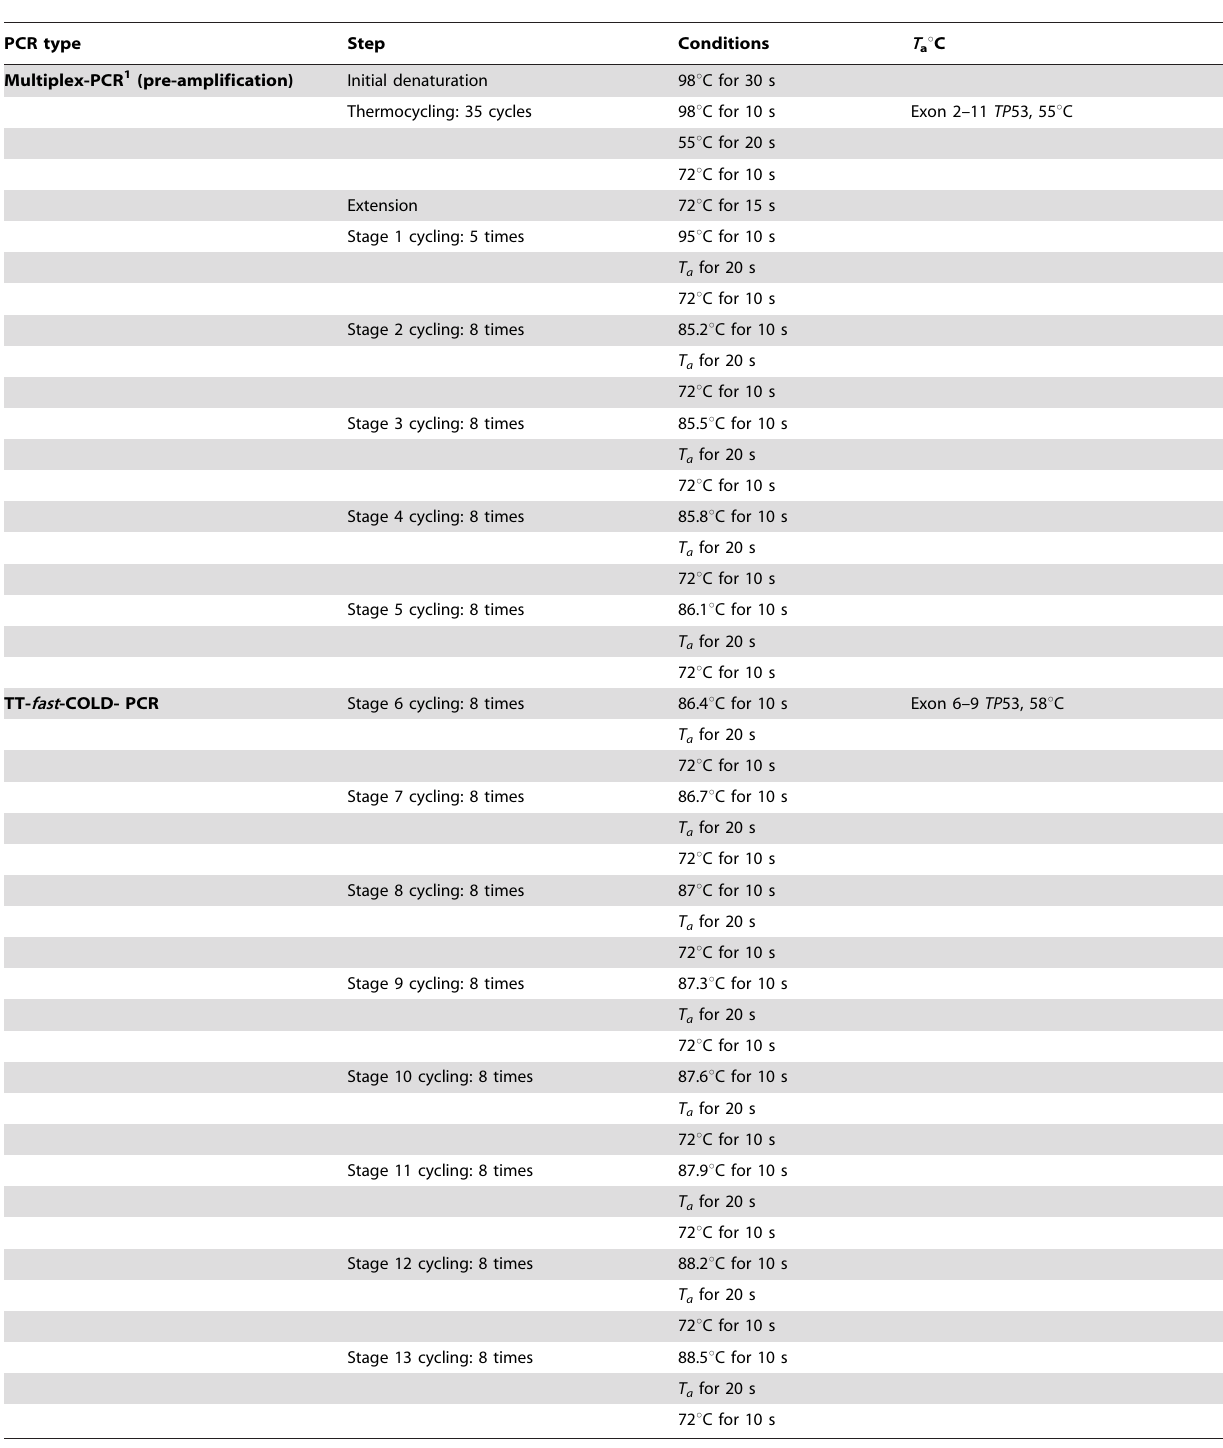
Table 3. PCR thermocycling conditions utilized in the present